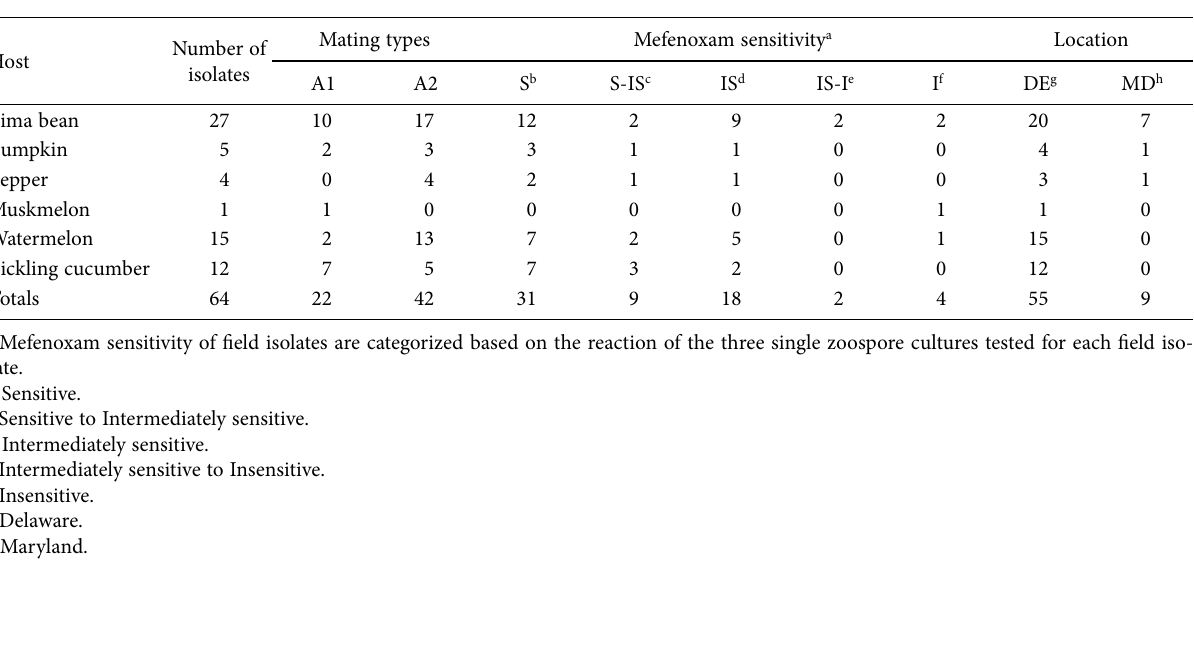
Table 1. Numbers of Phytophthora capsici isolates, their host sources, mating types, mefenoxam sensitivities, and locations, for isolates col- lected in the 2014, 2015 and 2016 field